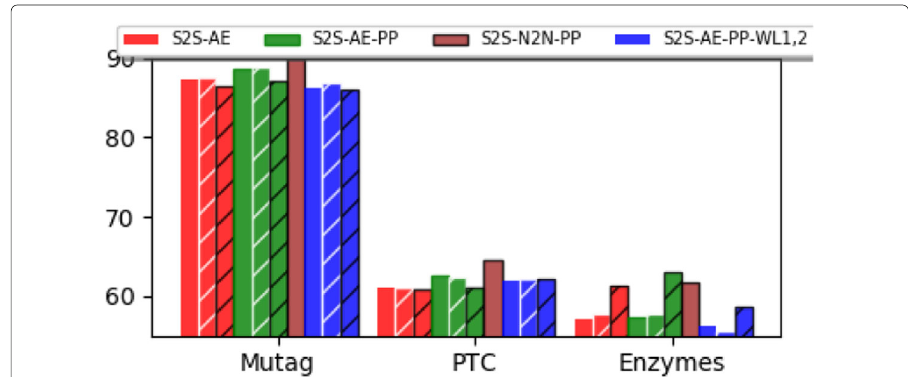
Fig. 12 Models (solid: RW, white hatch: BFS, black hatch:SP)